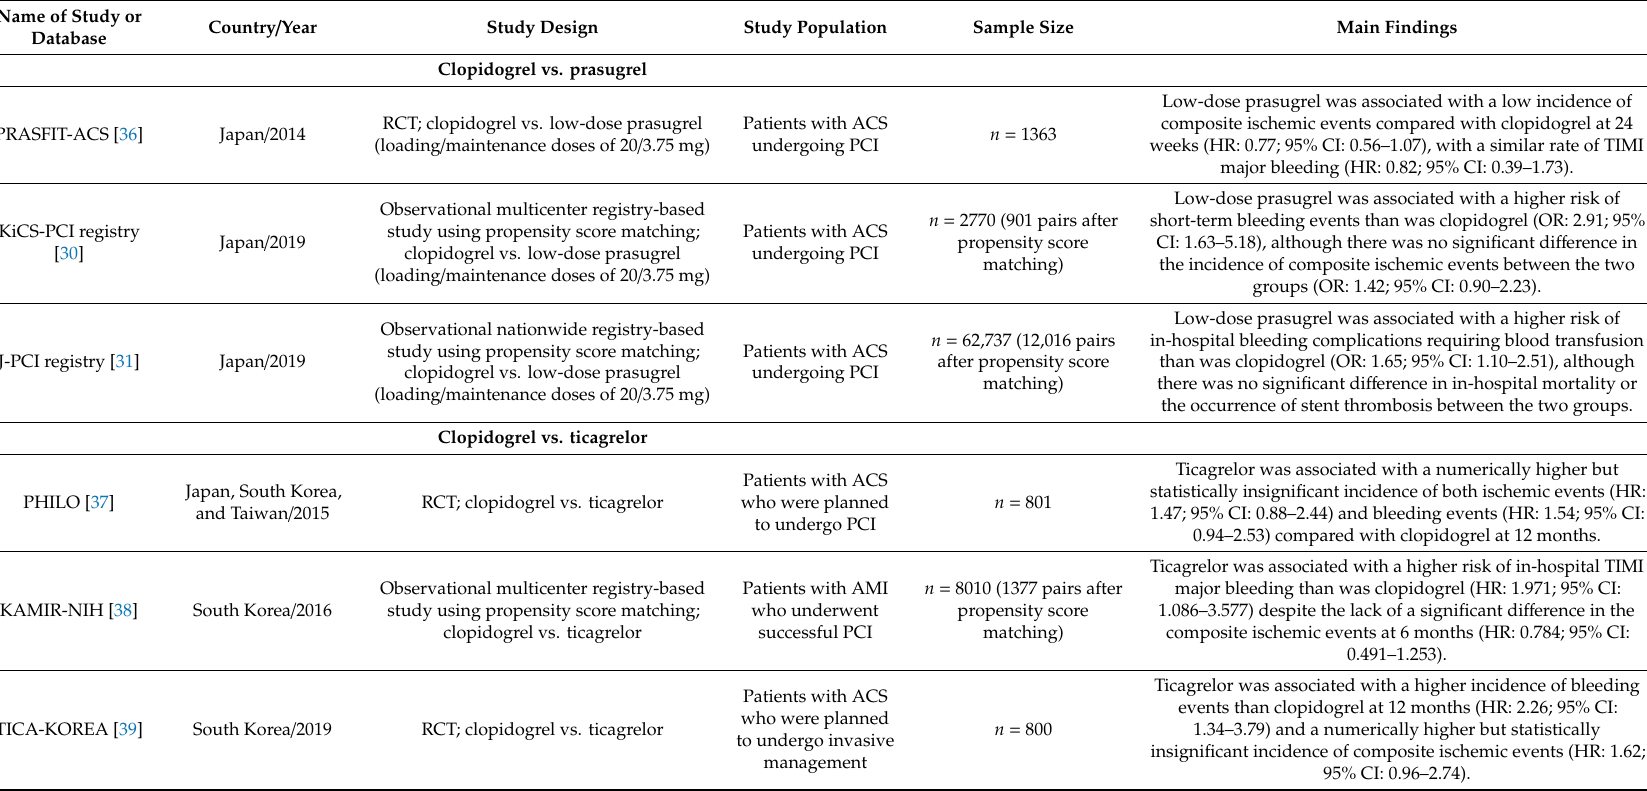
Table 2. Major clinical studies regarding the selection of P2Y12 inhibitors among East Asian patients with